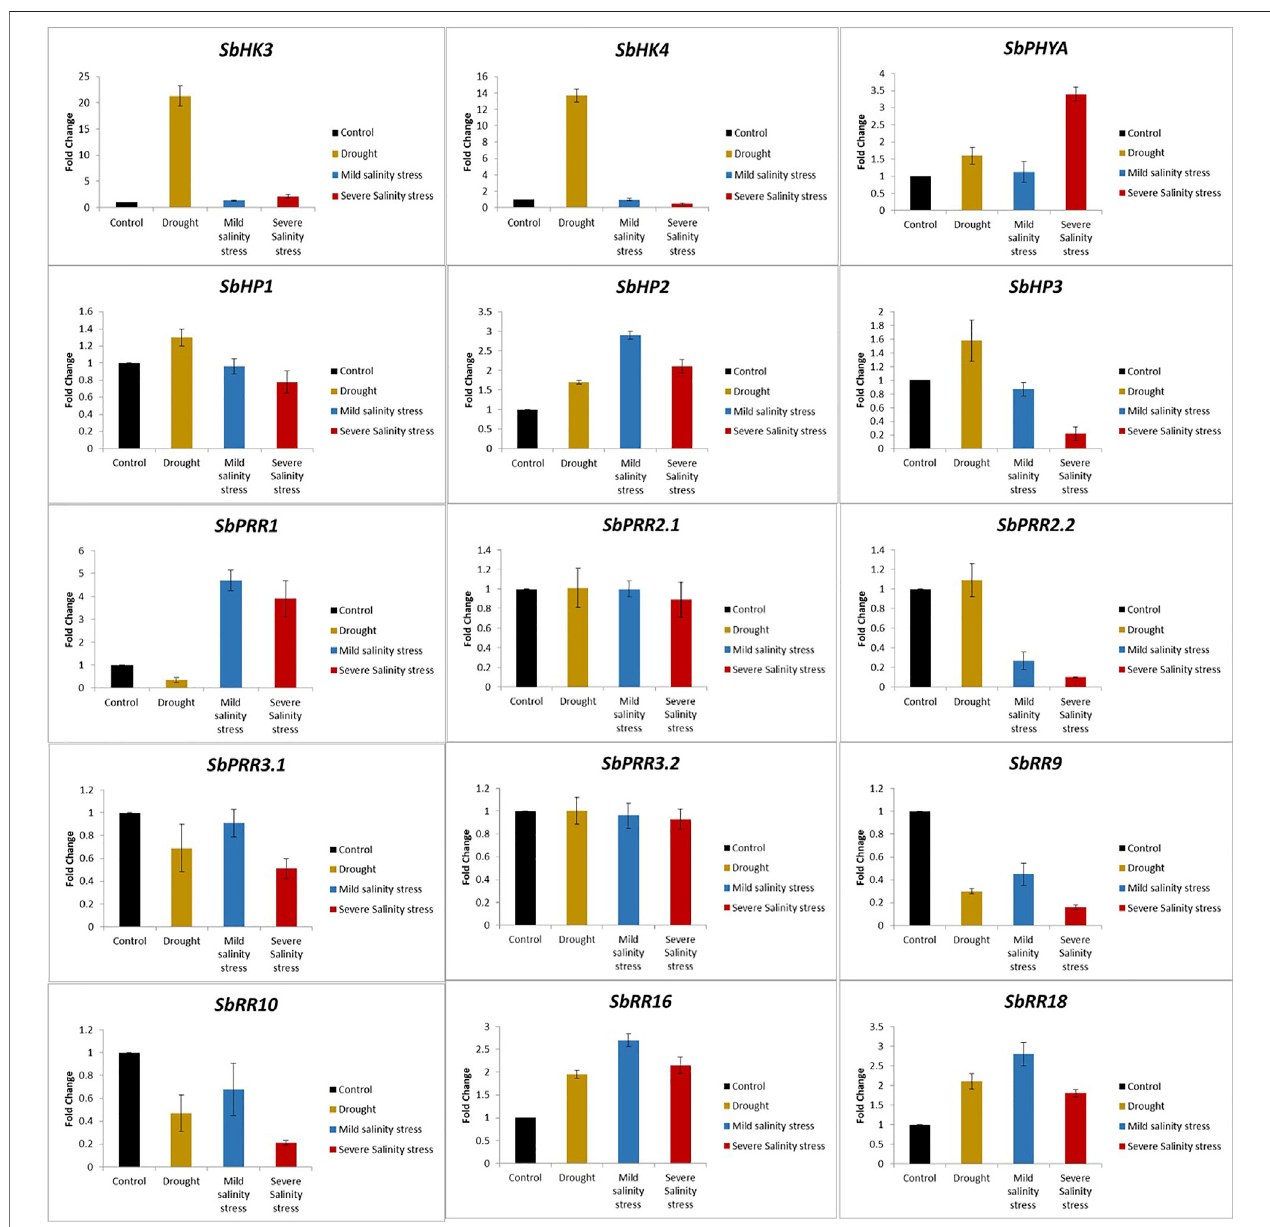
FIGURE 7 | Expression pro fi ling of TCS genes in response to drought (Yellow), mild salinity (Blue) and severe salinity (Red) stresses. Data represent means (SD) of three biological replicates. Vertical bars indicate standard deviations.